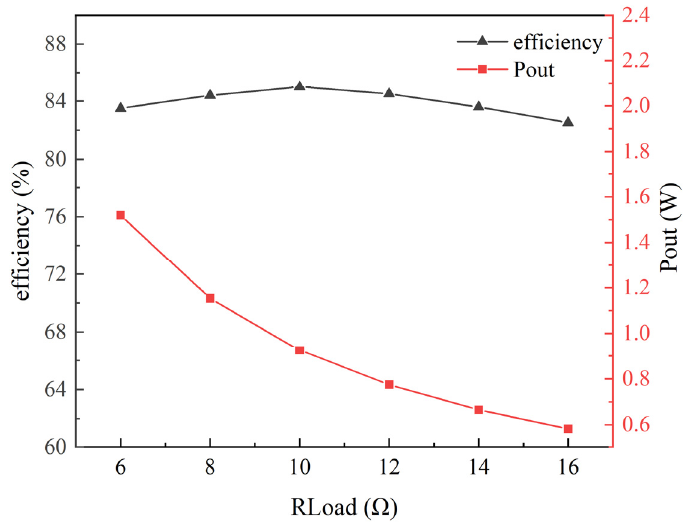
Figure 15. Simulation curve of output power and efficiency versus load resistance. Table 3. Performance comparison with the prior